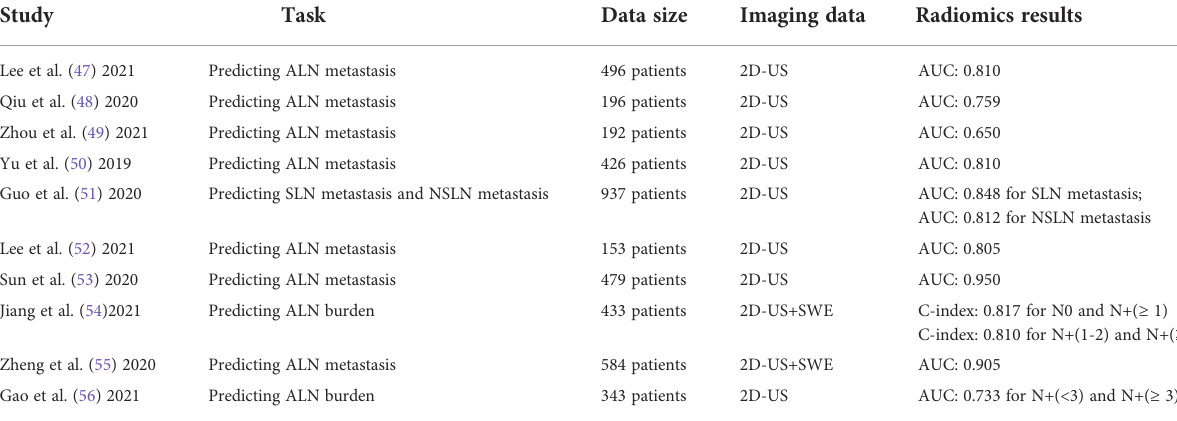
TABLE 3 Summary of ultrasound radiomics studies in predicting axillary lymph node status.